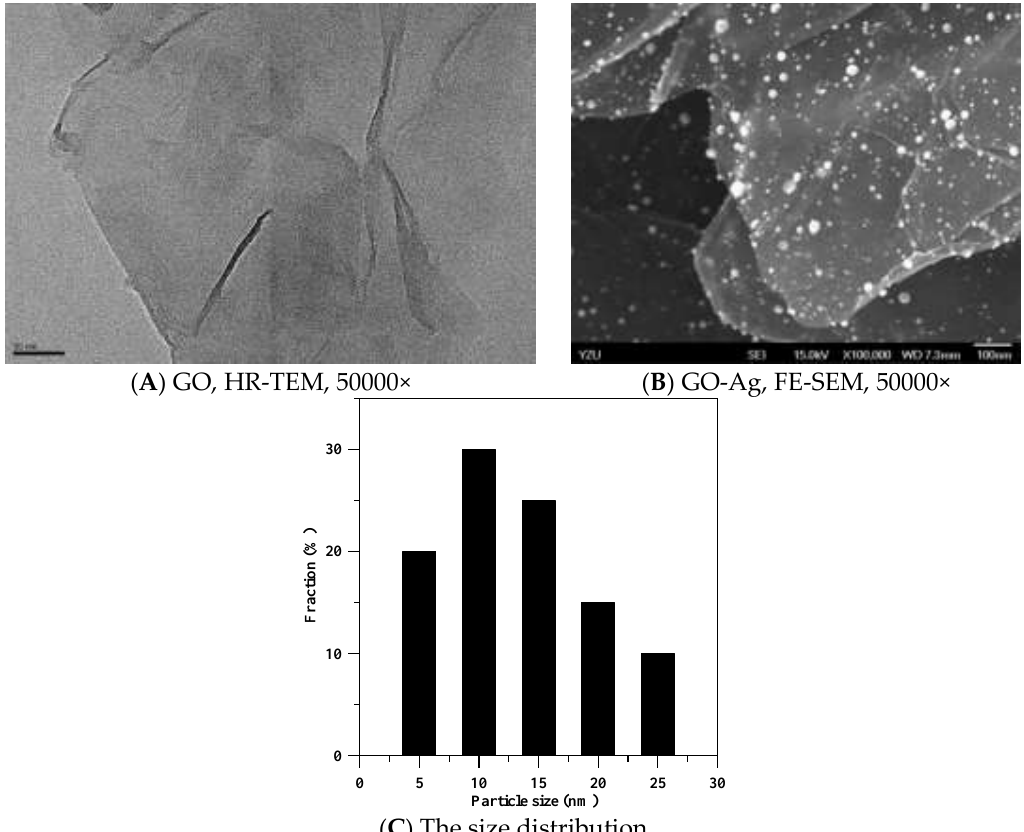
Figure 1. Morphology of graphene oxide sheets (GO) and silver nanoparticles on GO sheets (GO-Ag). ( A ) Image of GO sheets under high-resolution transmission electron microscopes (HR-TEM) at 50,000×; ( B ) image of GO-Ag under field-emission scanning electron microscopes (FE-SEM) at 50,000×; ( C ) the size distribution of Ag particles on GO sheet.